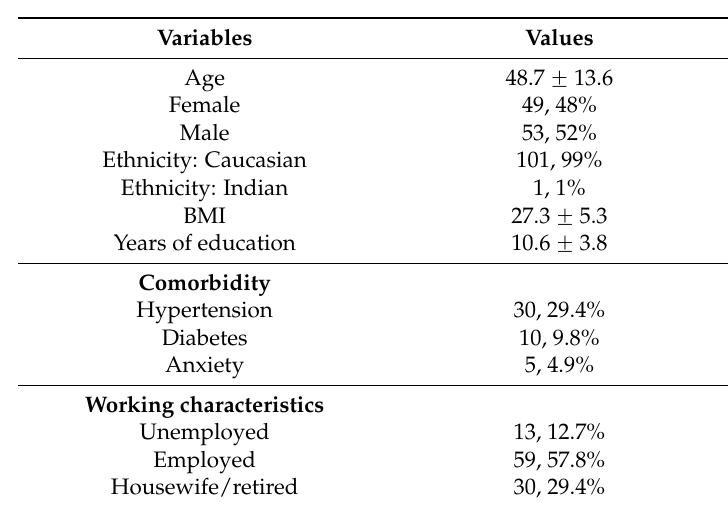
Table 1. General characteristics of the patients ( n :